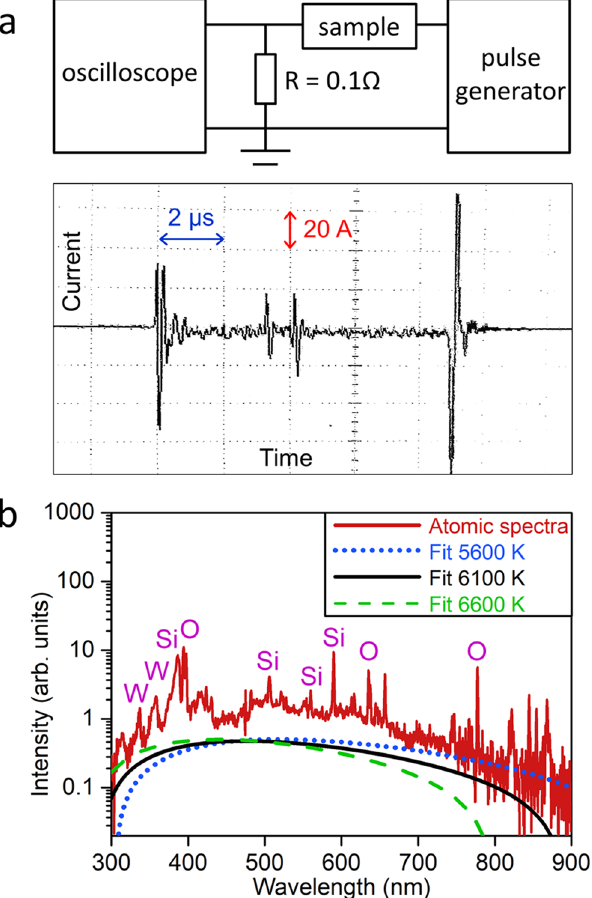
Figure 6. Electrically-triggered micro-explosions and atomic emission from GOS. ( a ) Schematic of current measurement during micro-explosions (top); measured current (bottom) from a n-Si GOS under inversion bias. ( b ) Optical emission spectrum measured during micro-explosions. Note the sharp atomic lines (labeled: S, O and W) and a blackbody radiation (broad continuous spectrum). The blackbody temperature is estimated to be ~6000 K (black solid curve